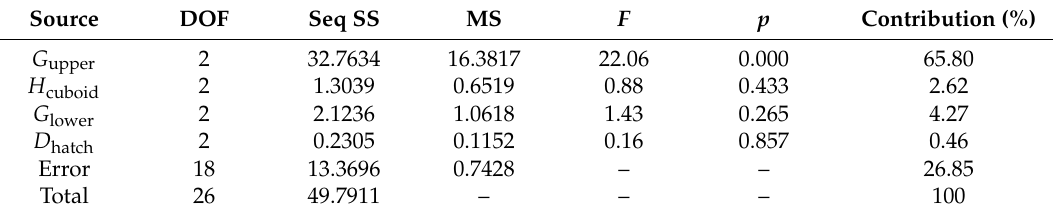
Table 8. ANOVA for Roughness ( R a ). R 2 =